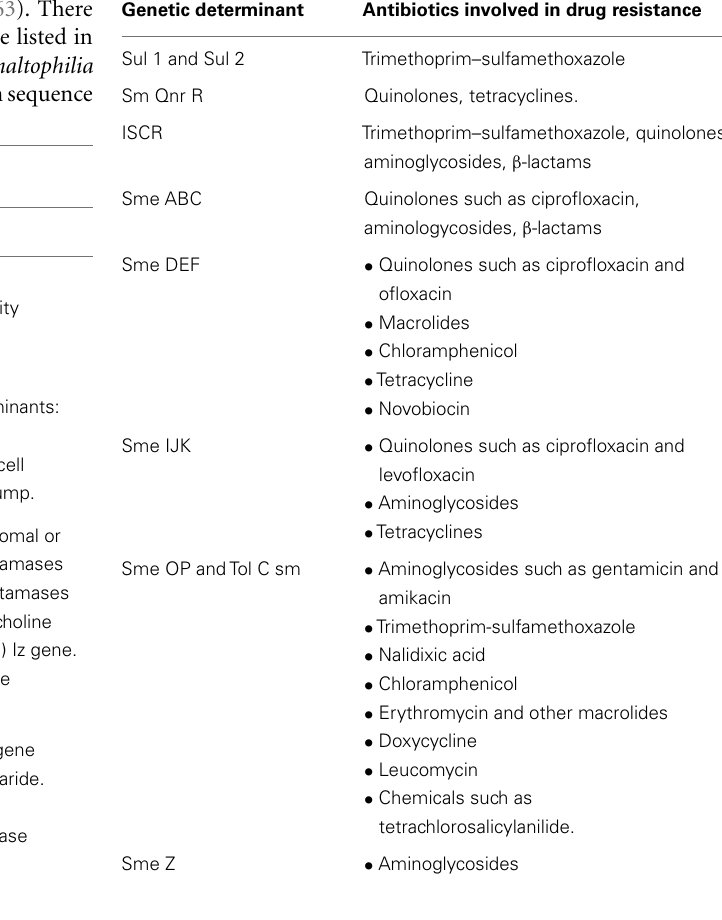
Table 5 | Genetic determinants of drug resistance